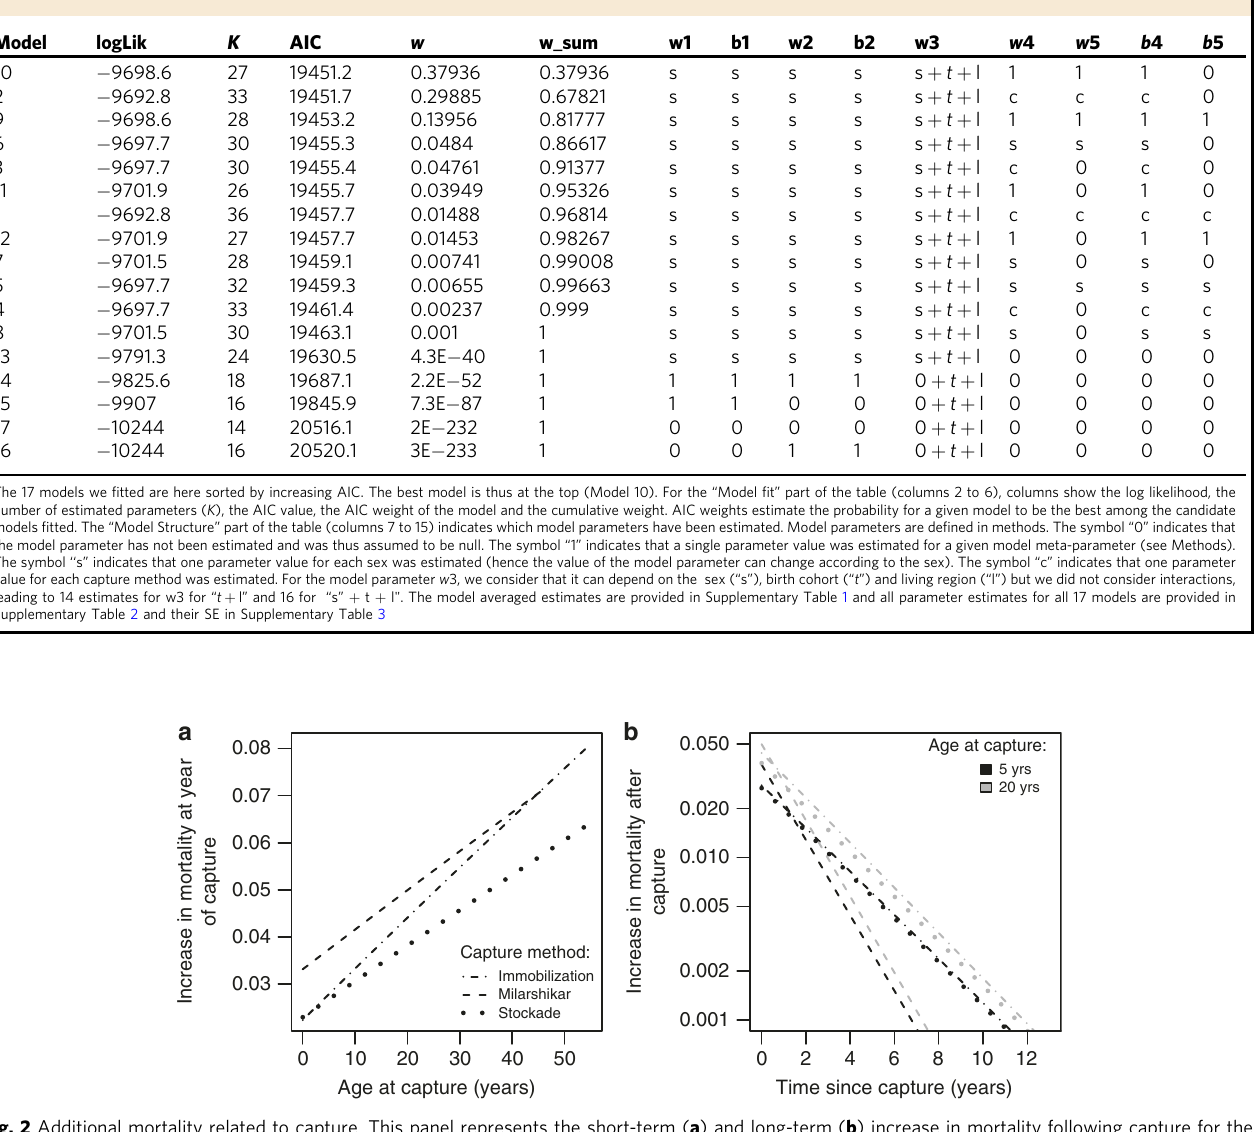
Table 1 Outcome of the model comparison.